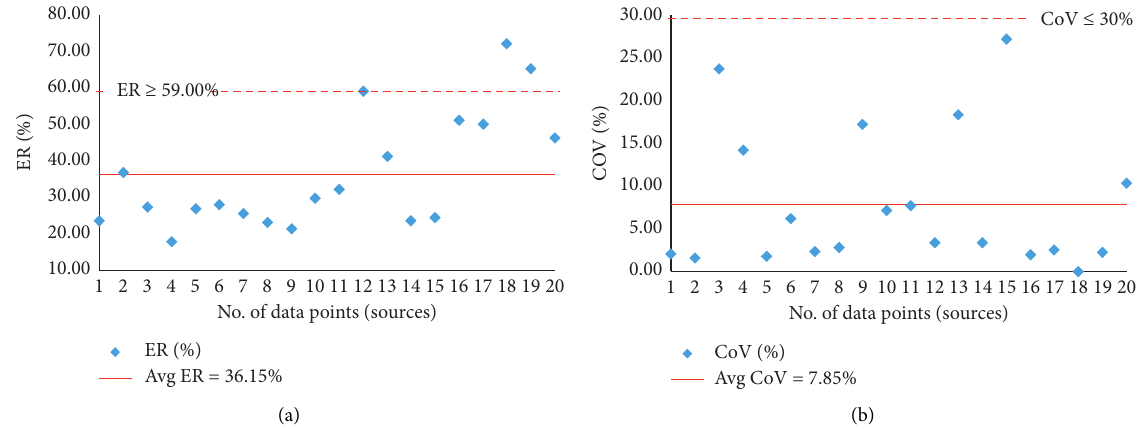
Figure 3: ER-CoV graphical